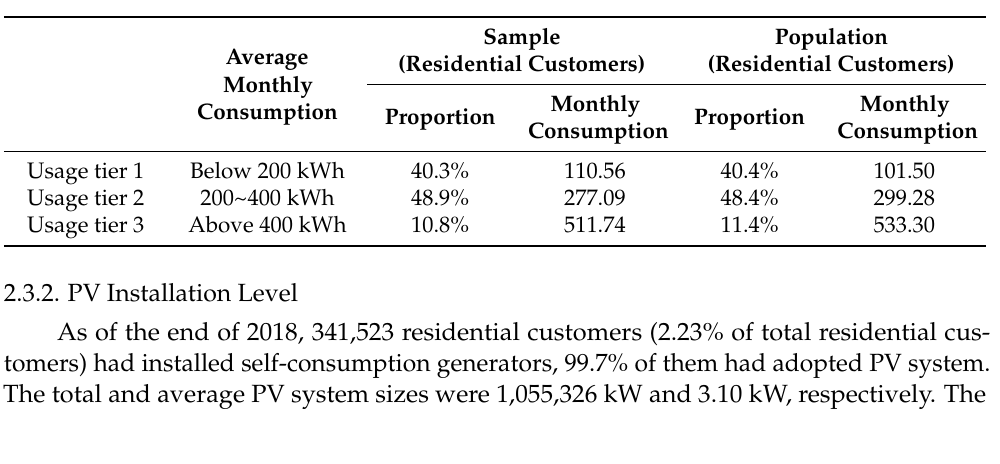
Table 2. Characteristics of sample and population for residential customer in Korea by usage